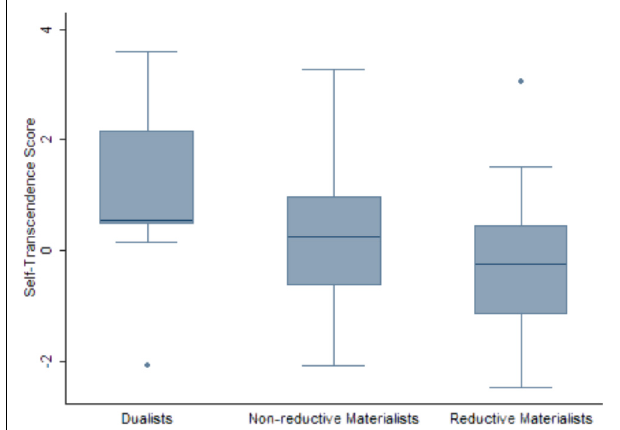
FIGURE 1 | Box plots of self-transcendence score for groups of dualists ( n = 9), non-reductive materialists ( n = 53), and reductive materialists ( n = 32).